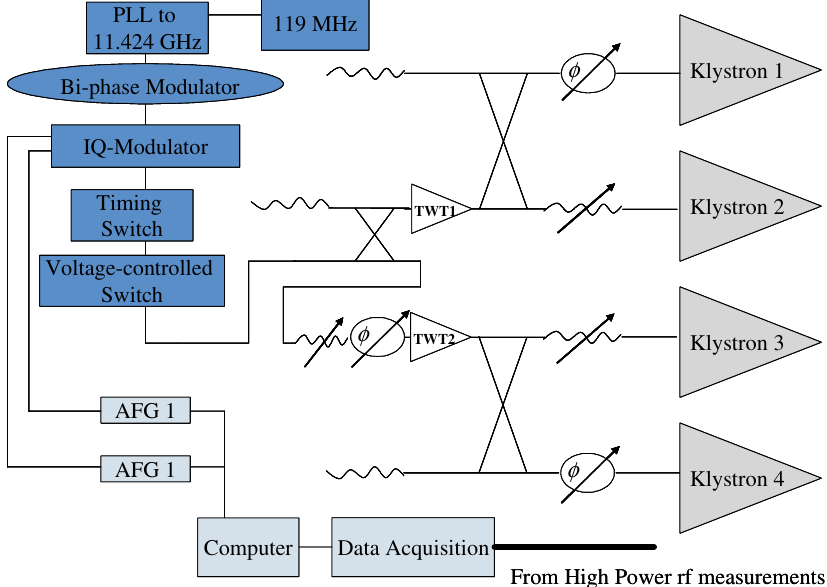
FIG. 26. (Color) Low-level rf system